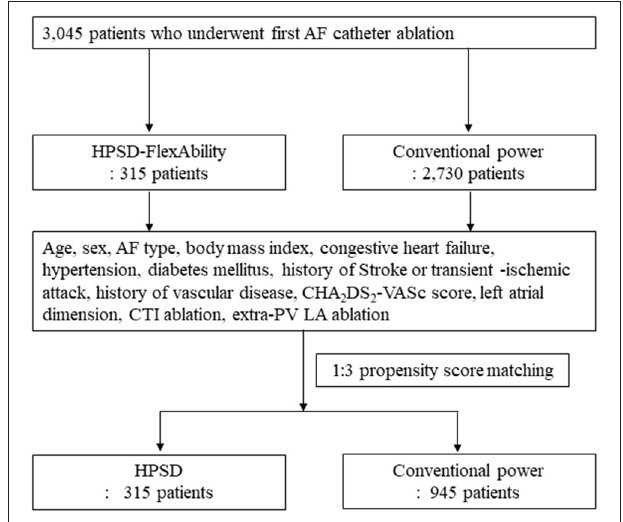
FIGURE 1 | Study flow chart, HPSD, high power short duration; AF, atrial